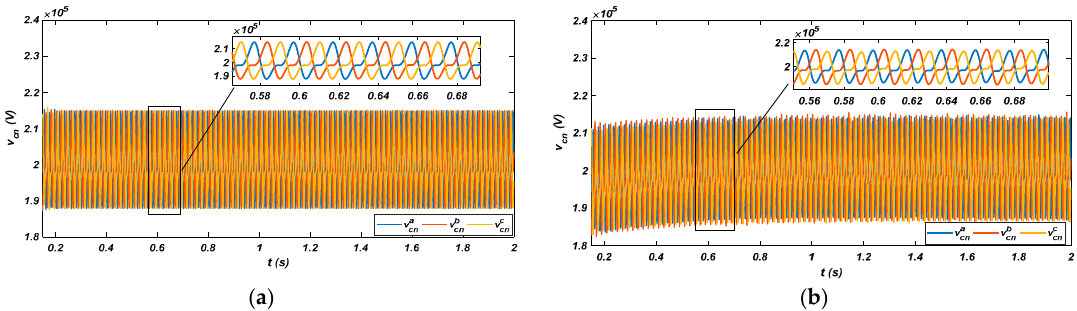
Figure 12. ( a ) Capacitor voltage of an upper arm using the API controller; ( b ) capacitor voltage of an upper arm using the PR controller.